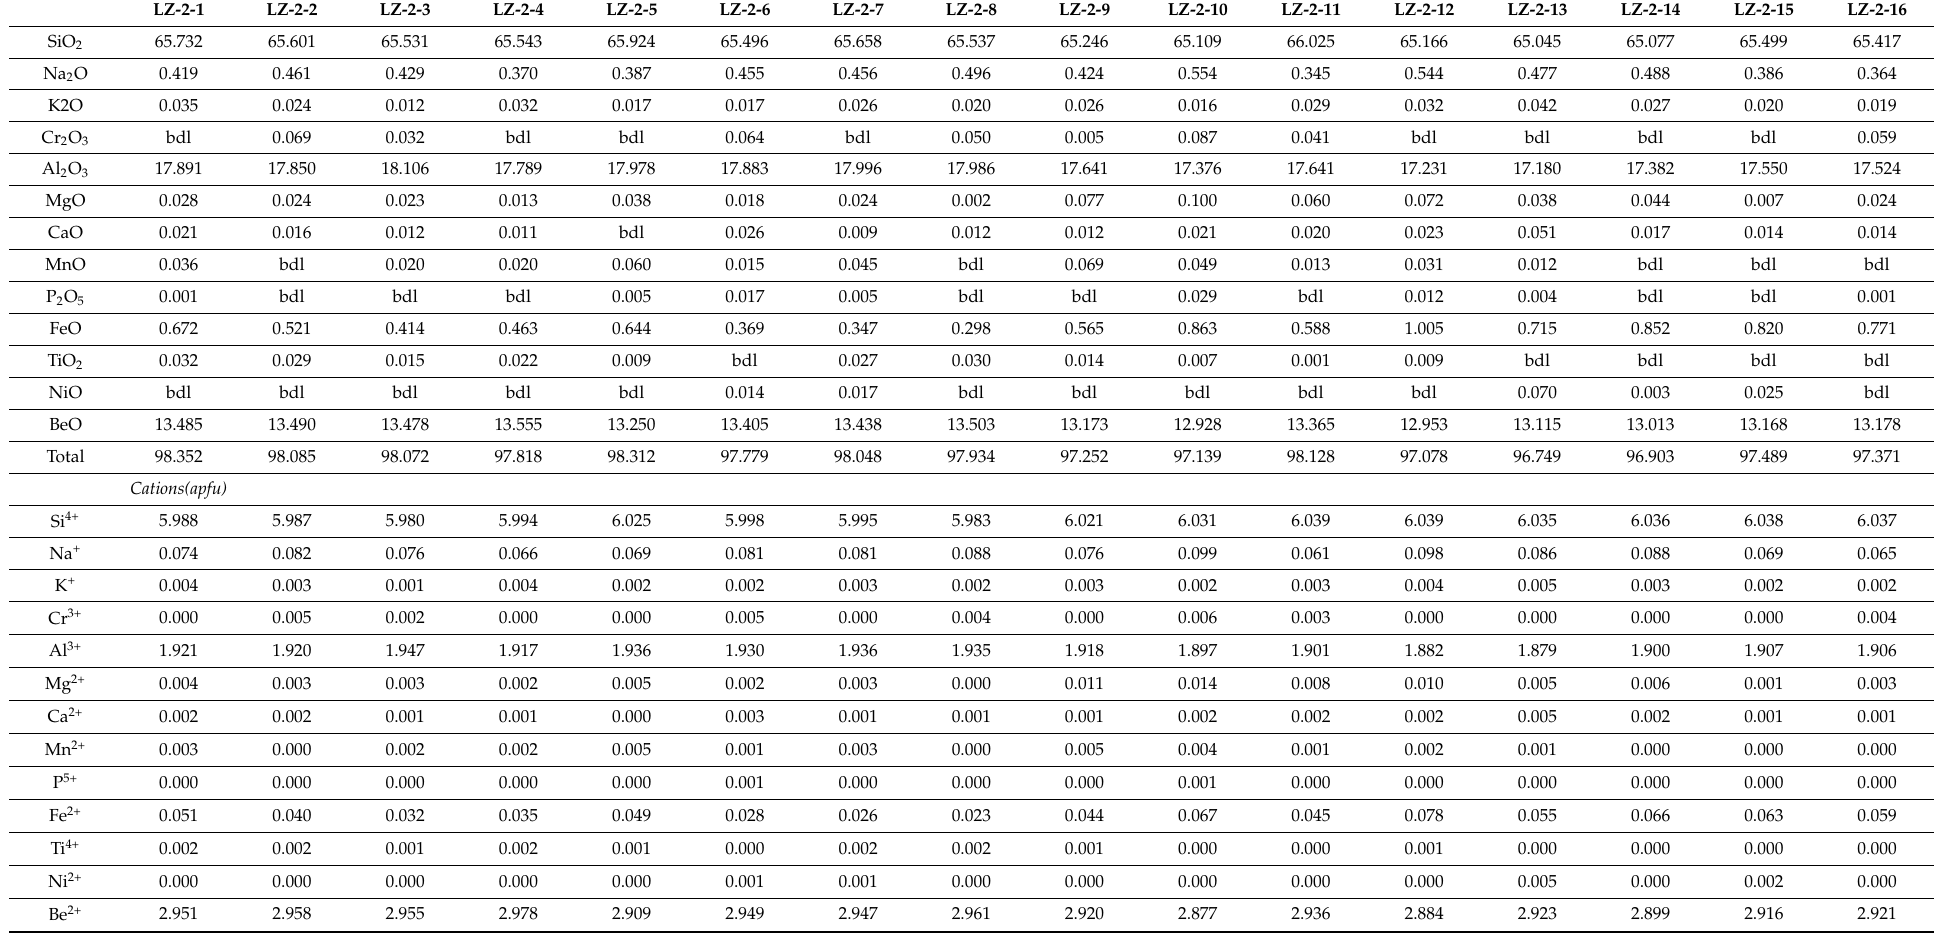
Table A1. Chemical compositions with the structural formulas of aquamarine and tourmalines from Longzi occurrence analyzed by EMPA (in